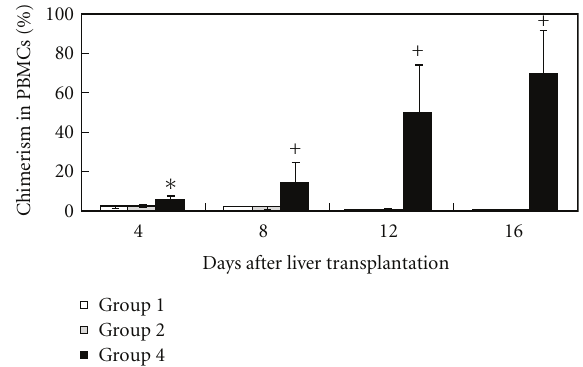
Figure 4: Changes of chimerism levels after liver transplantation. PBMC chimerism following sex-mismatched liver transplantation was identified by real-time PCR based on a rat Y-chromosome- specific primer, as described in Materials and Methods (Section 2). As described in Materials and Methods (Section 2), group 1 (white bars) received syngeneic liver transplantation, group 2 (gray bars) received semiallogeneic liver transplantation without splenocyte transfusion, and group 4 received semiallogeneic liver transplantation together with the transfusion of 4 × 10 8 splenocytes. Each group consisted of 6 animals. ∗ P < . 05, + P < . 01 (compared with groups 1 and 2).